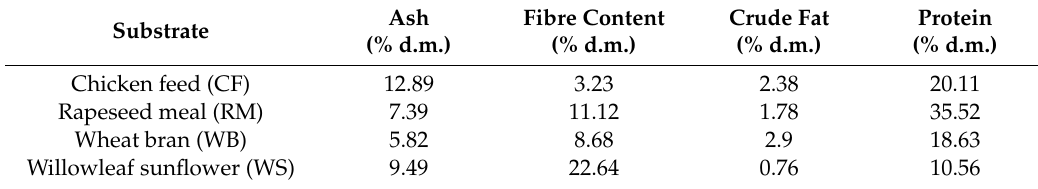
Table 1. Main components of chicken feed (control) and industrial residues used for di ff erent diets.